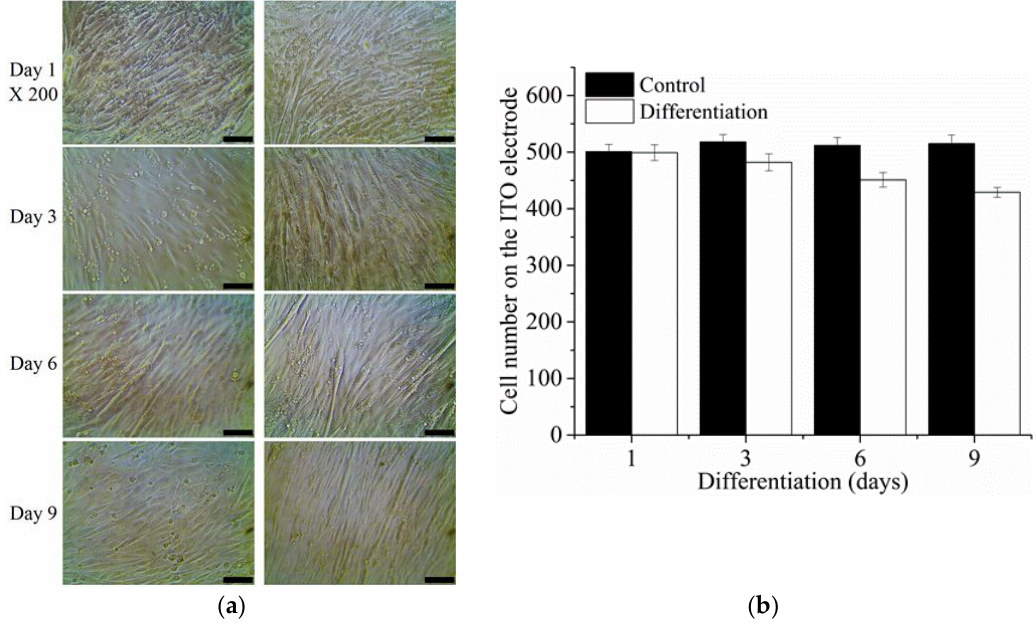
Figure 3. ( a ) Phase contrast micrograph (scale bar: 100 μm) and ( b ) counted number of C2C12 cells cultured on the extracellular matrix gel-coated ITO working electrode with or without differentiation medium.